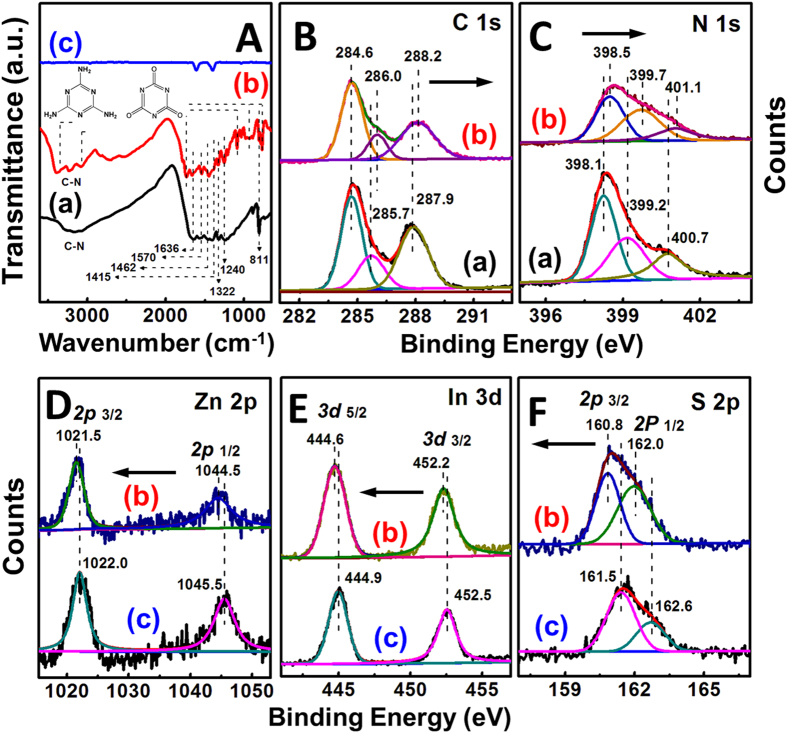
(A) FT-IR spectra of the as-synthesized samples: (a) g-C3N4 nanosheets, (b) 15 wt% ZnIn2S4/g-C3N4 heterojunction nanosheets, and (c) ZnIn2S4 nanosheets; XPS spectra of the as-synthesized samples: (B) C 1s core-level spectra; (C) N 1s core-level spectra: (a) g-C3N4 nanosheets, (b) 15 wt% ZnIn2S4/g-C3N4 heterojunction nanosheets; (D) Zn 2p core-level spectra; (E) In 3d core-level spectra; (F) S 2p core-level spectra: (b) 15 wt% ZnIn2S4/g-C3N4 heterojunction nanosheets, and (c) ZnIn2S4 nanosheets.